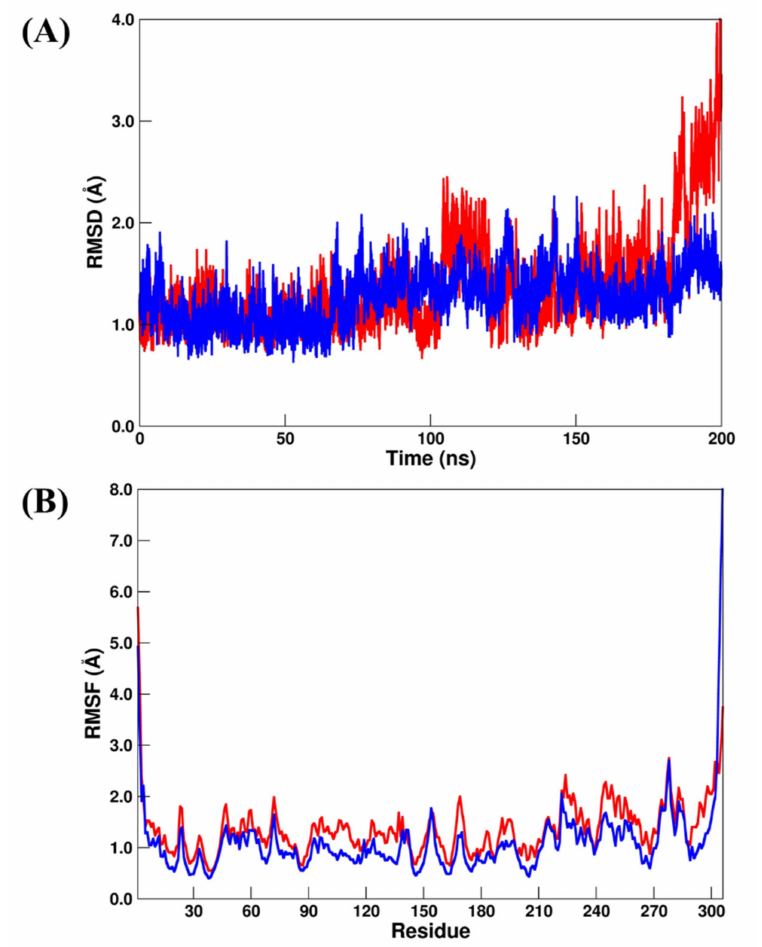
Figure 4. ( A ) RMSD and ( B ) RMSF plots for Mpro–X77 (red line) and Mpro–OUB (blue line). All values are reported in